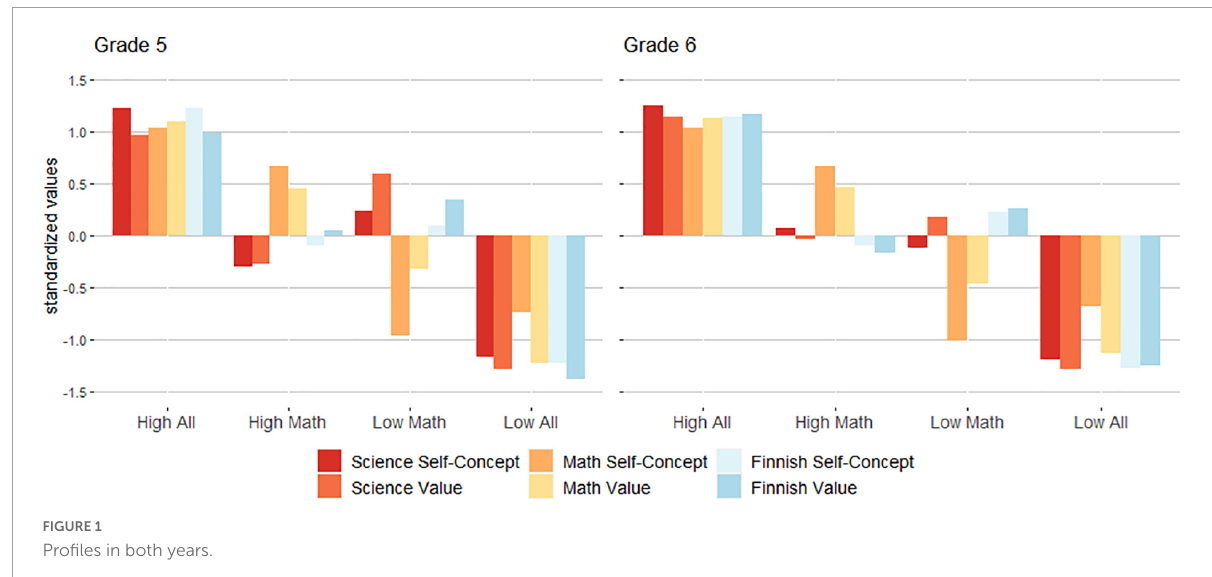
FIGURE1 Profiles in both